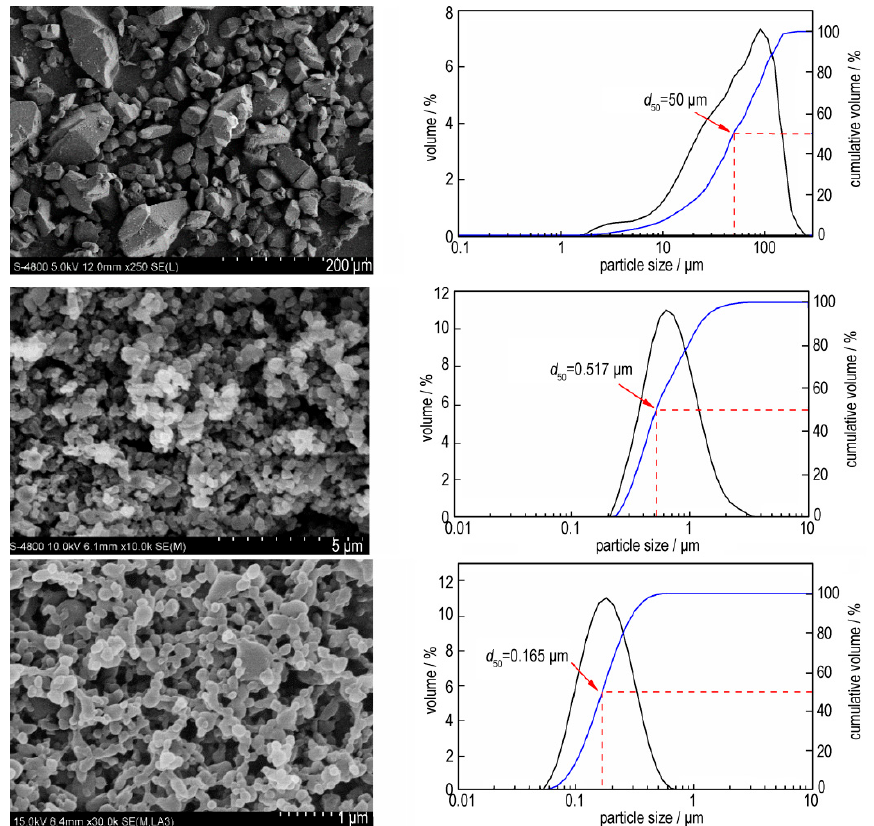
Figure 2. SEM images and particle size distributions of CL ‐ 20 with different particle sizes. Reproduced from [32], with permission from Chinese Journal of Energetic Materials (Han Neng Cai Liao), 2019.